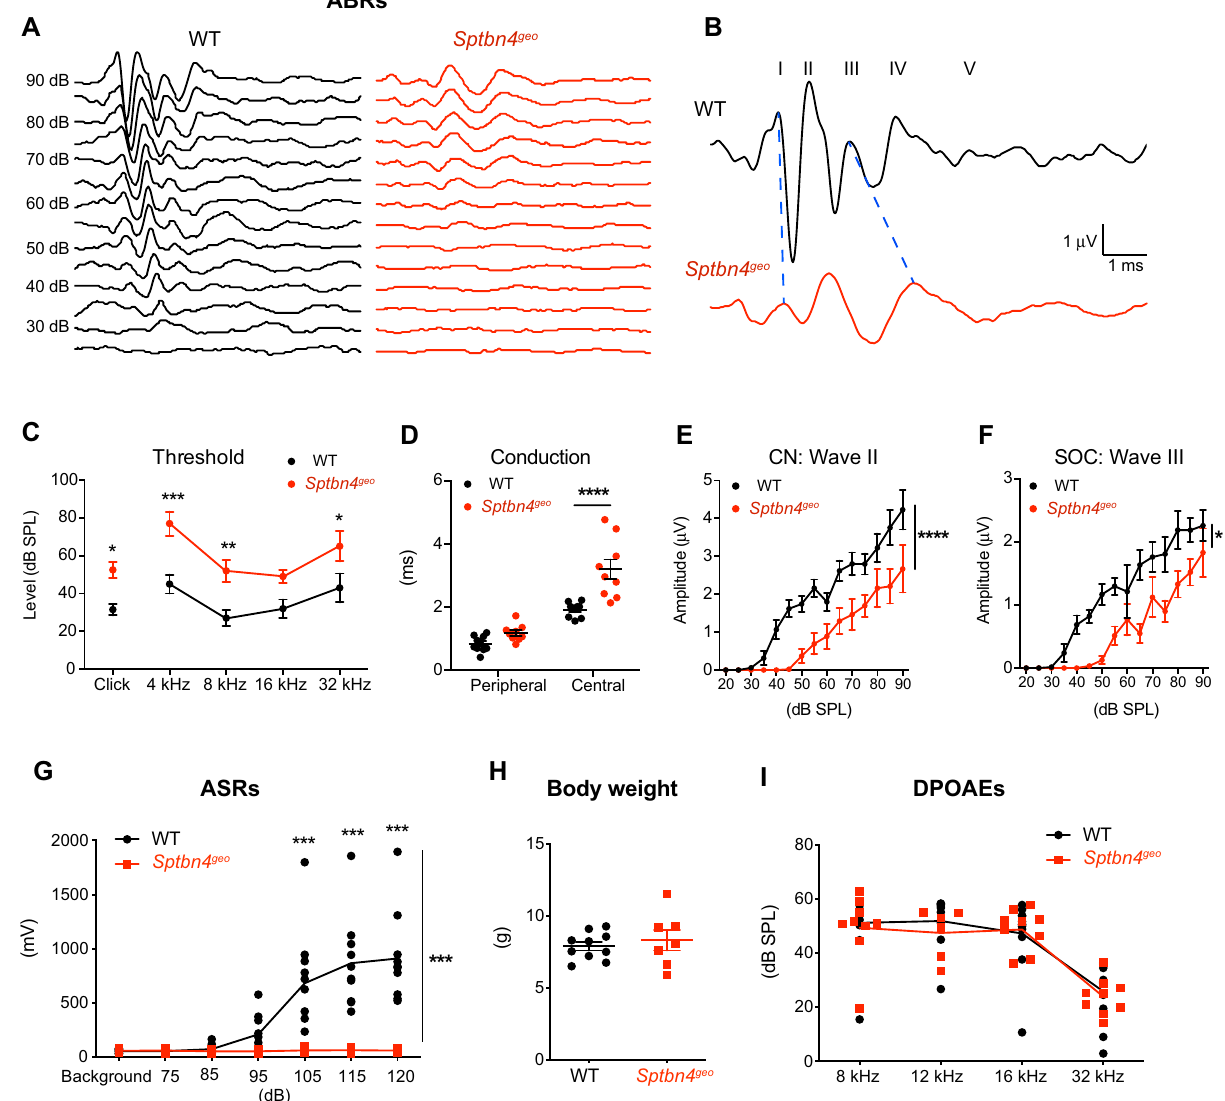
Figure 4. Loss of β4-spectrin impairs conduction and synchrony of neuronal activity in the central auditory brainstem. ( A ) Representative traces of ABRs in response to click stimuli (from 25 to 90 dB) from WT and Sptbn4 geo mice (at P25). ( B ) Magnified ABR traces in response to click stimulus at 85 dB. Roman numerals indicate waves I-V in WT mice. Blue dashed lines identify corresponding waves I and III in Sptbn4 geo mice. ( C ) Summary of ABR thresholds of WT and Sptbn4 geo mice (P21-P25) in response to click and pure tones 4, 8, 16, and 32 kHz. ( D ) Peripheral and central conduction in WT and Sptbn4 geo mice. Peripheral conduction was measured as the inter-peak interval between positive peaks I–II in ABRs (at 85 dB). Central conduction was measured as the time difference between positive peaks II–IV. ( E–F ) Summary of ABR amplitudes (µV) of wave II corresponding with the cochlear nucleus (CN, E ) and wave III with the superior olivary complex (SOC, F ) across 20 to 90 dB in WT and Sptbn4 geo mice. Amplitudes were measured as the µV difference between the positive peak and the preceding negative peak. ABRs: WT = 10 mice; Sptbn4 geo = 9 mice. ( G ) Summary of ASR maximum startle amplitudes (mV) to noise stimuli (background = 65 dB to 120 dB). ( H ) Summary of body weights (g) of WT and Sptbn4 geo mice. ( I ) Summary of distortion products (dB SPL) at 80 dB at various noise tones (8, 12, 16, and 32 kHz). ASRs, body weight, & DPOAEs: WT = 9 mice, Sptbn4 geo = 7 mice. All values plotted are means per mouse ± s.e.m. (* p < 0.05, ** p < 0.01, *** p < 0.001, **** p < 0.0001 two-way ANOVA with Bonferroni’s